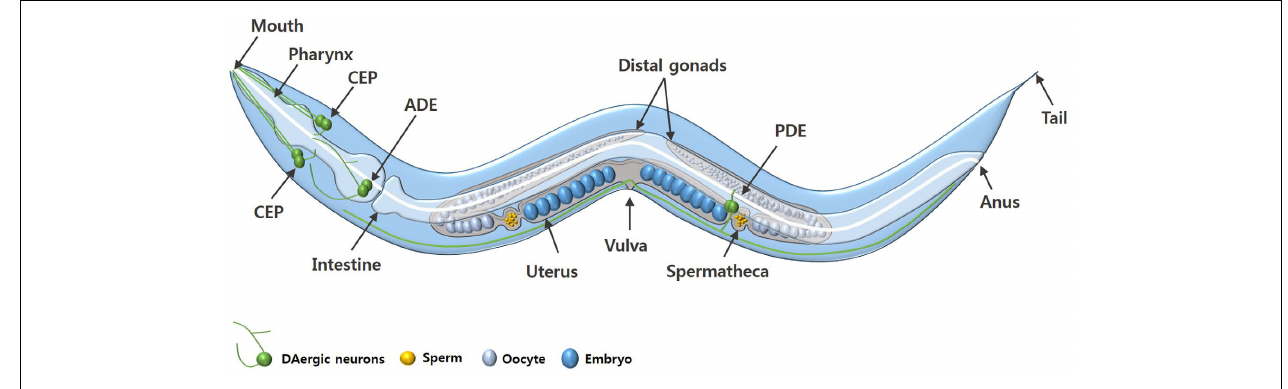
FIGURE 1 | An adult C. elegans hermaphrodite. The diagram shows the key anatomical features and the DAergic neurons (green) of C. elegans . The DAergic neurons include four cephalic (CEP) neurons,